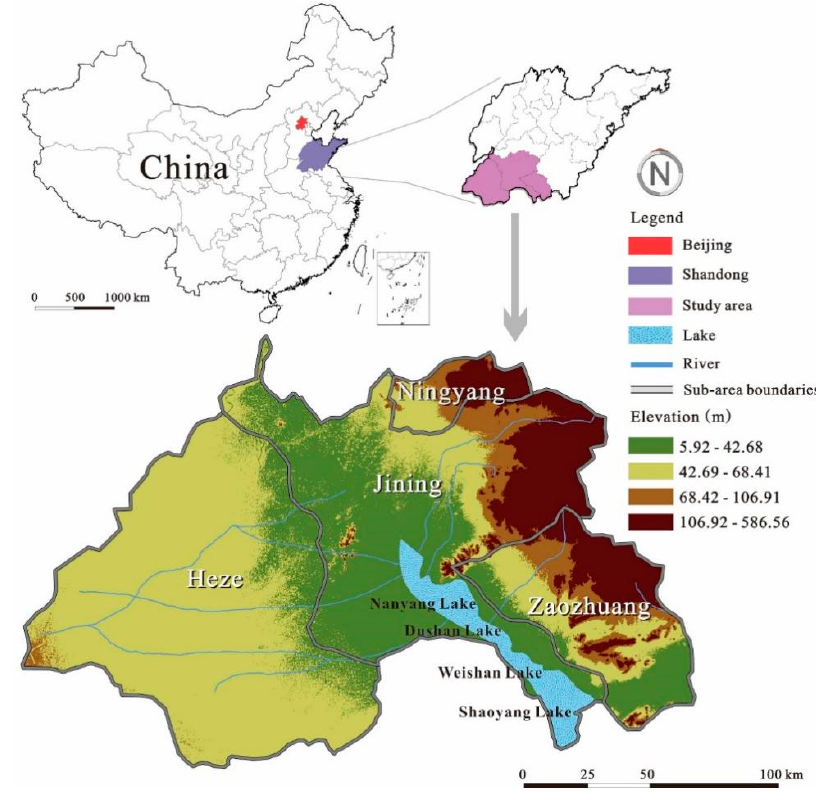
Figure 1. The study